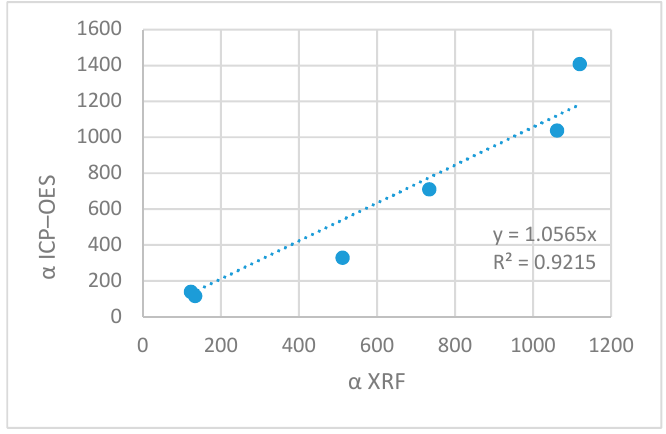
Figure 5. Enrichment coefficient determined by XRF vs. ICP-OES.